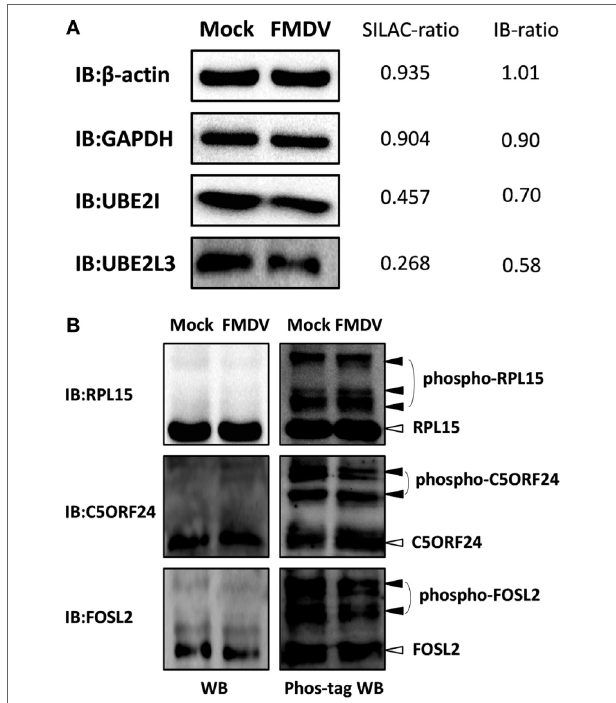
FigUre 2 | Confirmation of differentially expressed proteins and phosphoproteins by western blotting and Phos-tag western Blotting. (a) Analysis of ubiquitin conjugating enzyme E2 I, ubiquitin conjugating enzyme E2 L3, glyceraldehyde-3-phosphate dehydrogenase, β -actin expression levels in foot-and-mouth disease virus (FMDV)-infected and control cells by western blotting. SILAC-ratios and immunoblotting ratios (infection/control) were shown on the right side. (B) Analysis of the dynamic phosphorylation alterations of the three differentially phosphoproteins (ribosomal protein L15, chromosome 5 open reading frame 24, and FOS-like 2) in FMDV-infected and control cells by Phos-tag western